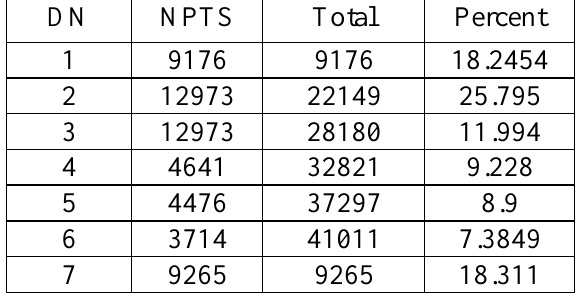
Table 2: The classes, (NPTS) and percent for each one of